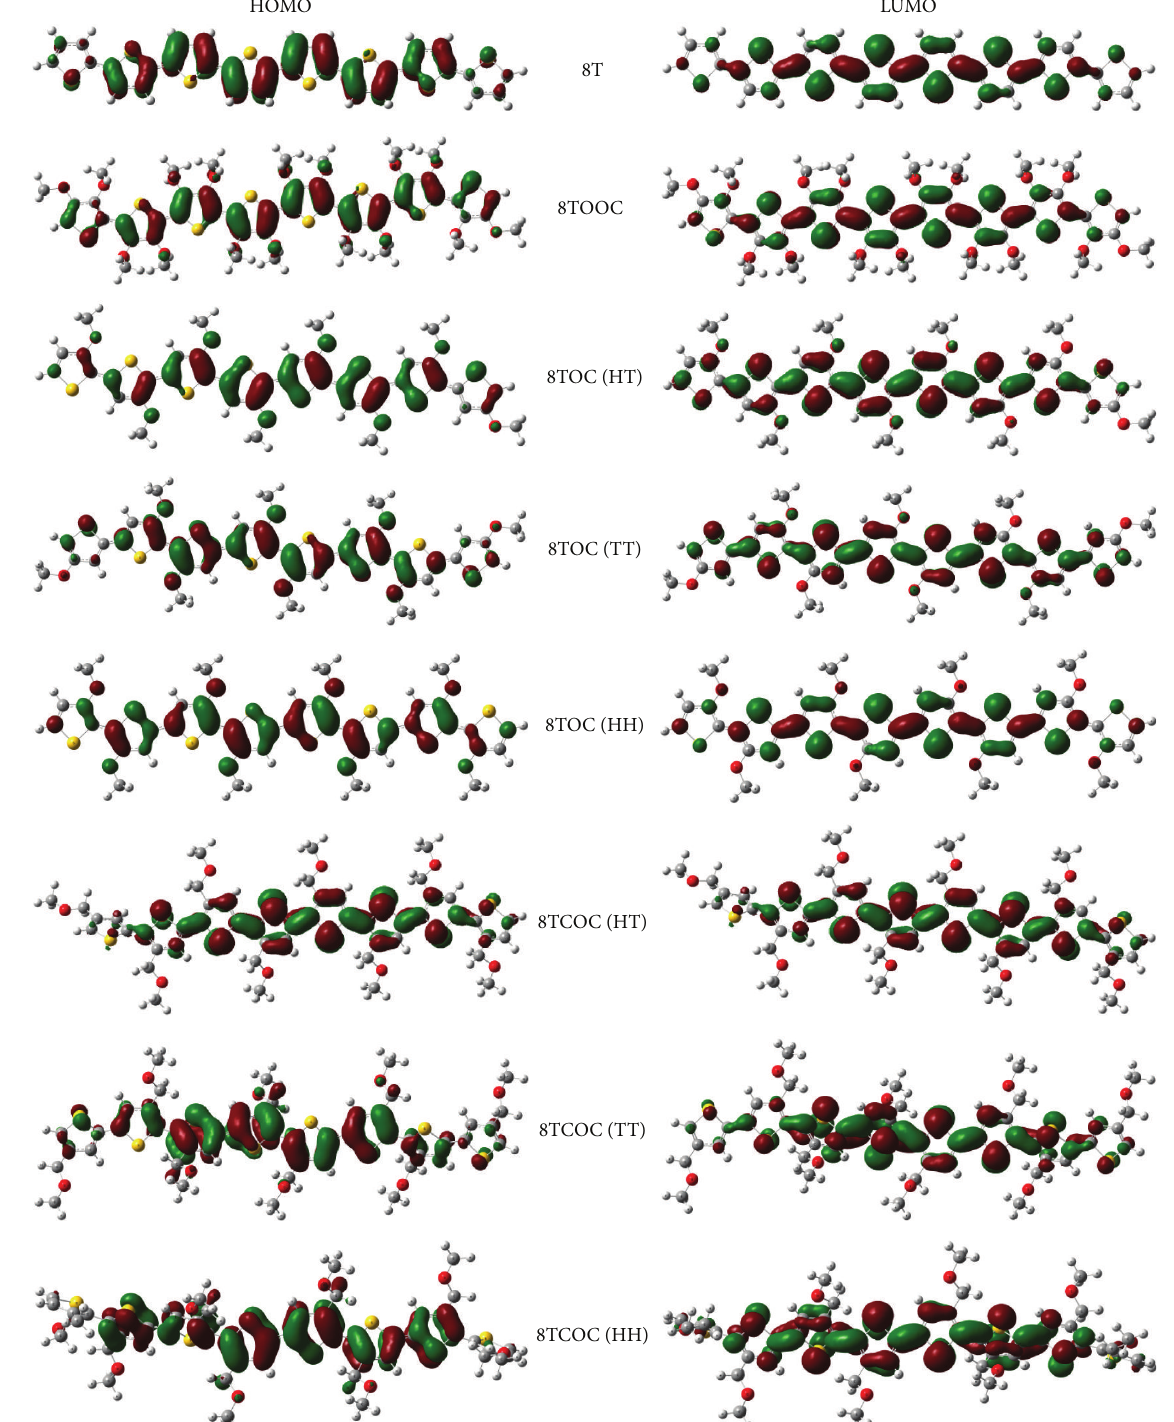
Figure 5: The contour plots of HOMO and LUMO orbitals of the studied